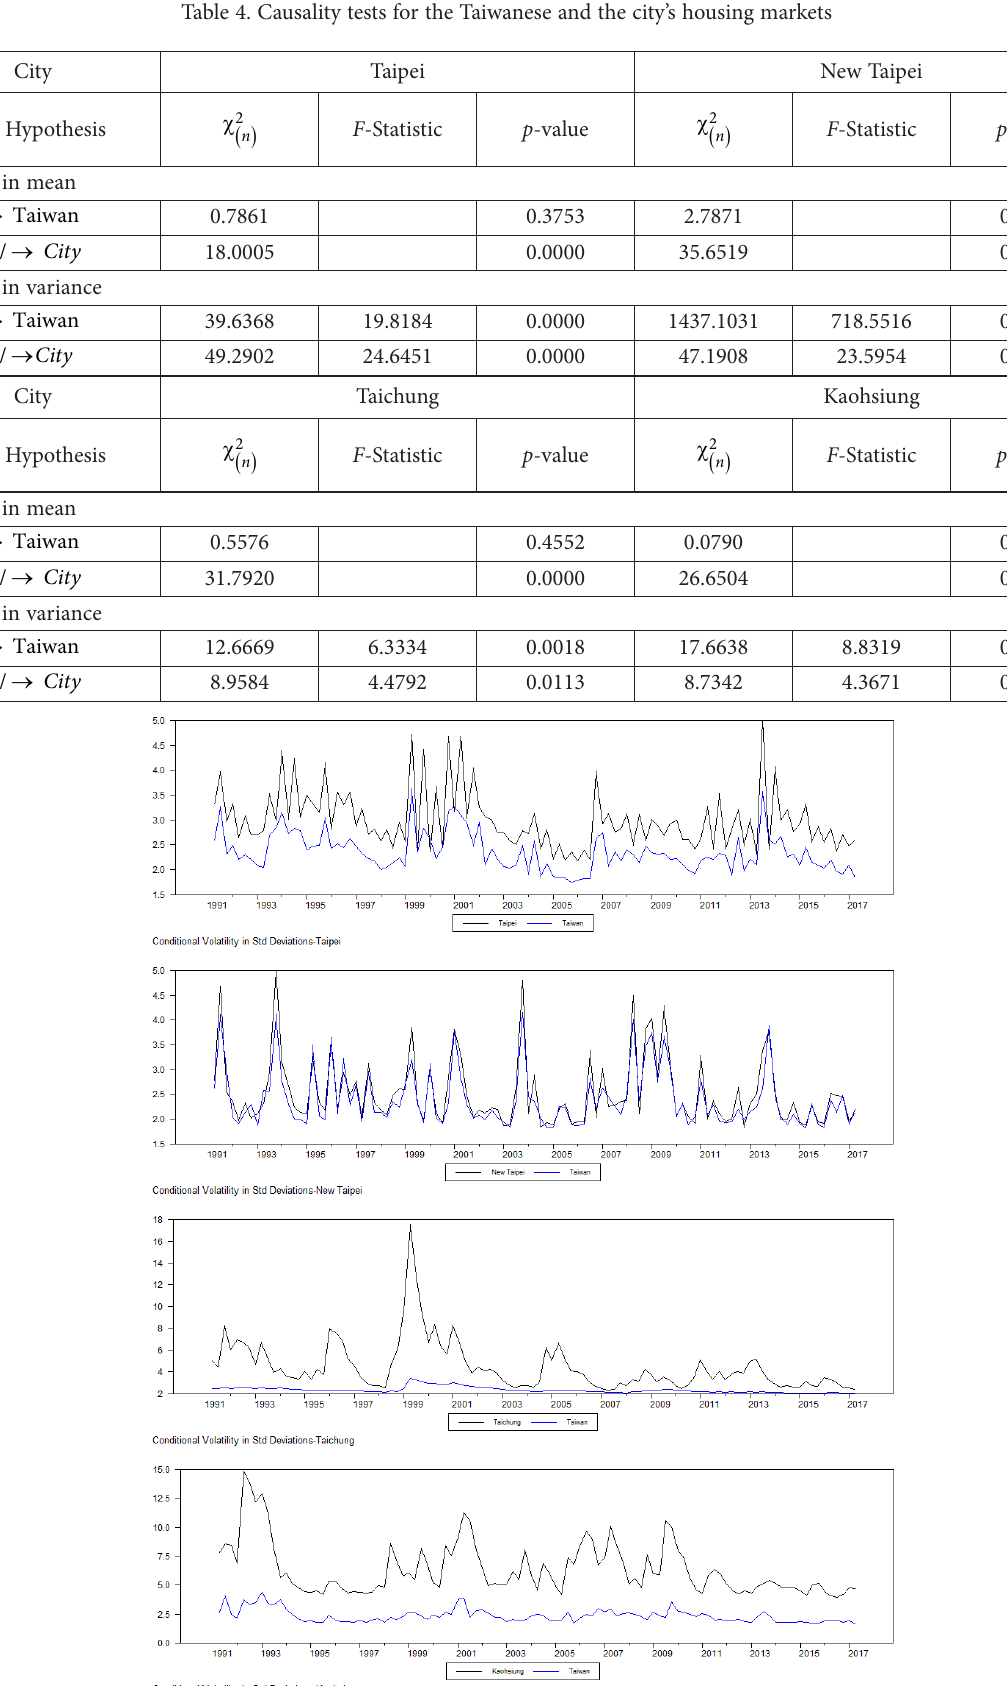
Figure 3. Conditional